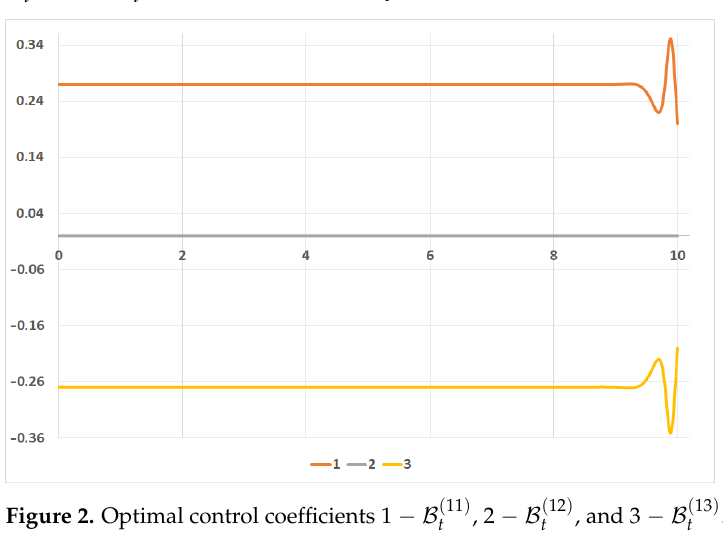
Figure 2. Optimal control coefficients 1 − B